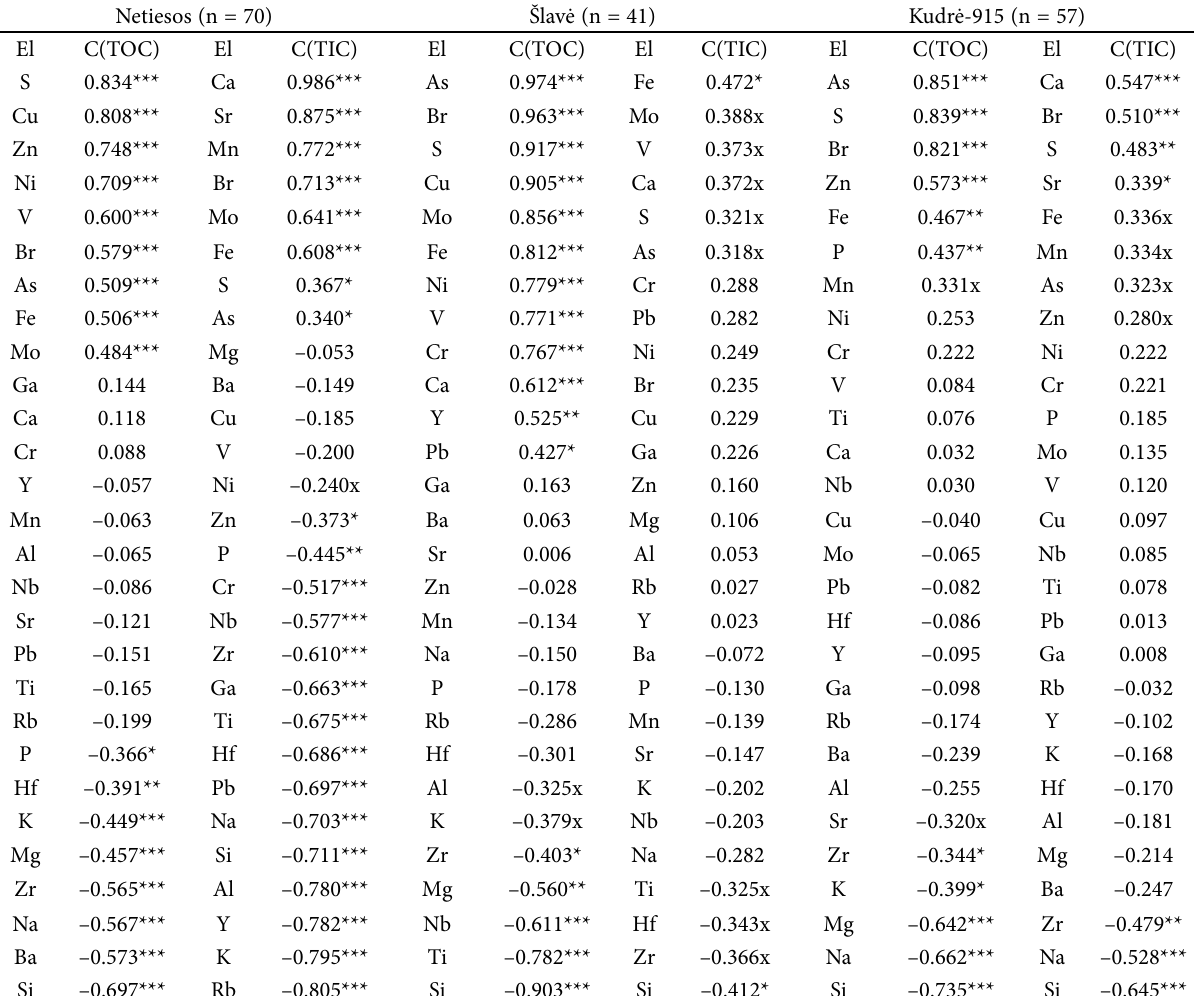
Fig. 6. Relationship of As and Mo to main components of palaeolake Netiesos sediments. NCM: non-carbonate minerals, TCB: total carbonates, OM: organic matter. Table 3. Correlation of chemical elements with total organic carbon and total inorganic carbon in three